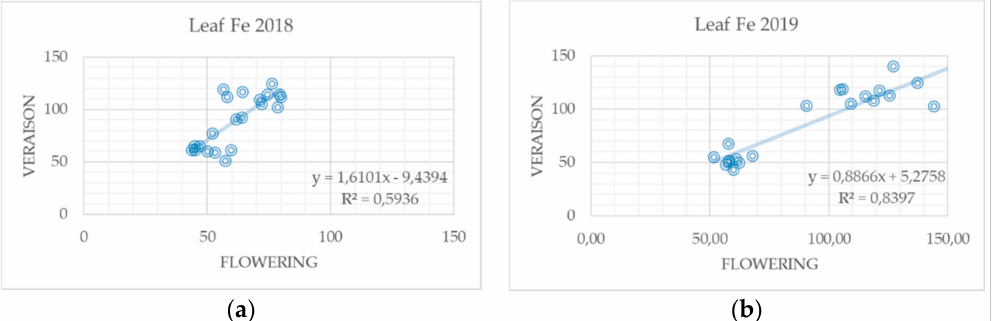
Figure 4. Correlations between the Fe content in leaf tissues at flowering and veraison phase in 2018 ( a ) and 2019 ( b ); n = 21.